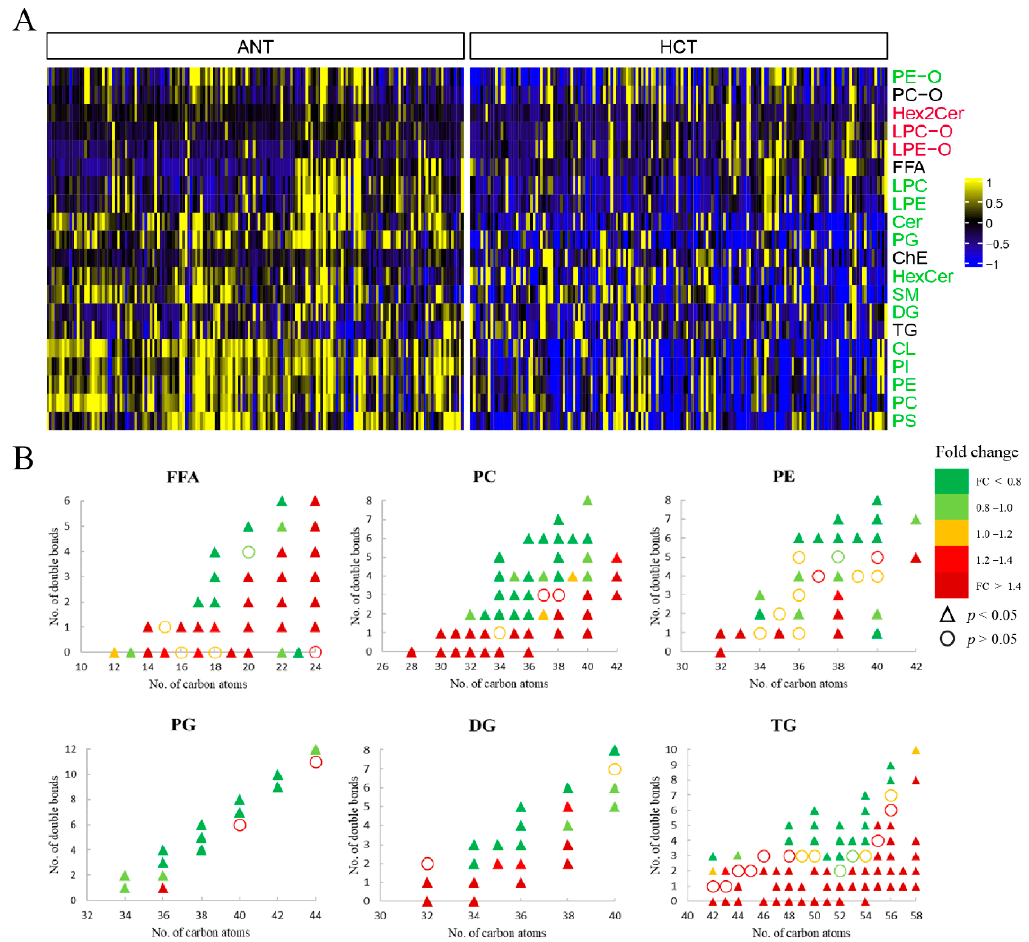
Figure 3. Association between HCC and lipid structure. ( A ) Heatmap of the lipid abundance changes by class between ANT and HCT samples. ( B ) Alteration of lipids with significant difference by carbon number and double bond number.